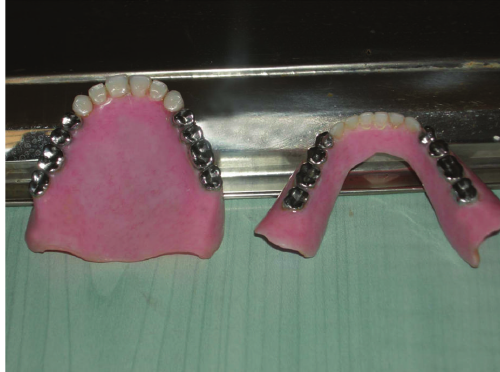
Figure 3: Custom metal occlusal surfaces for acrylic resin denture teeth.